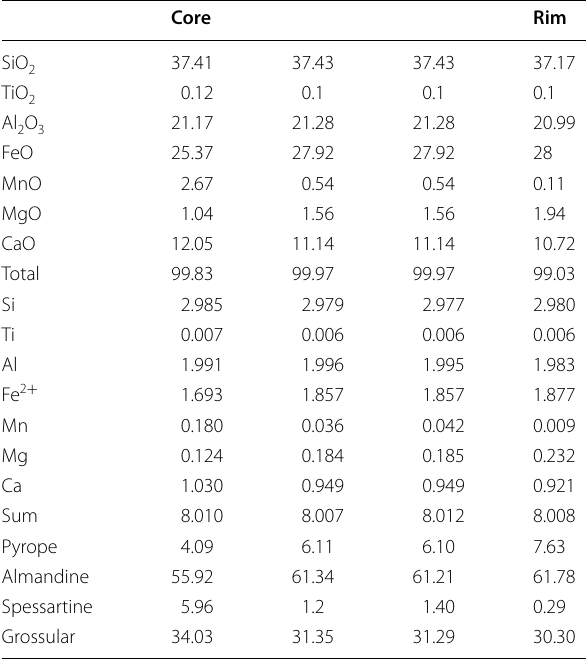
Total includes traces of Na.K and